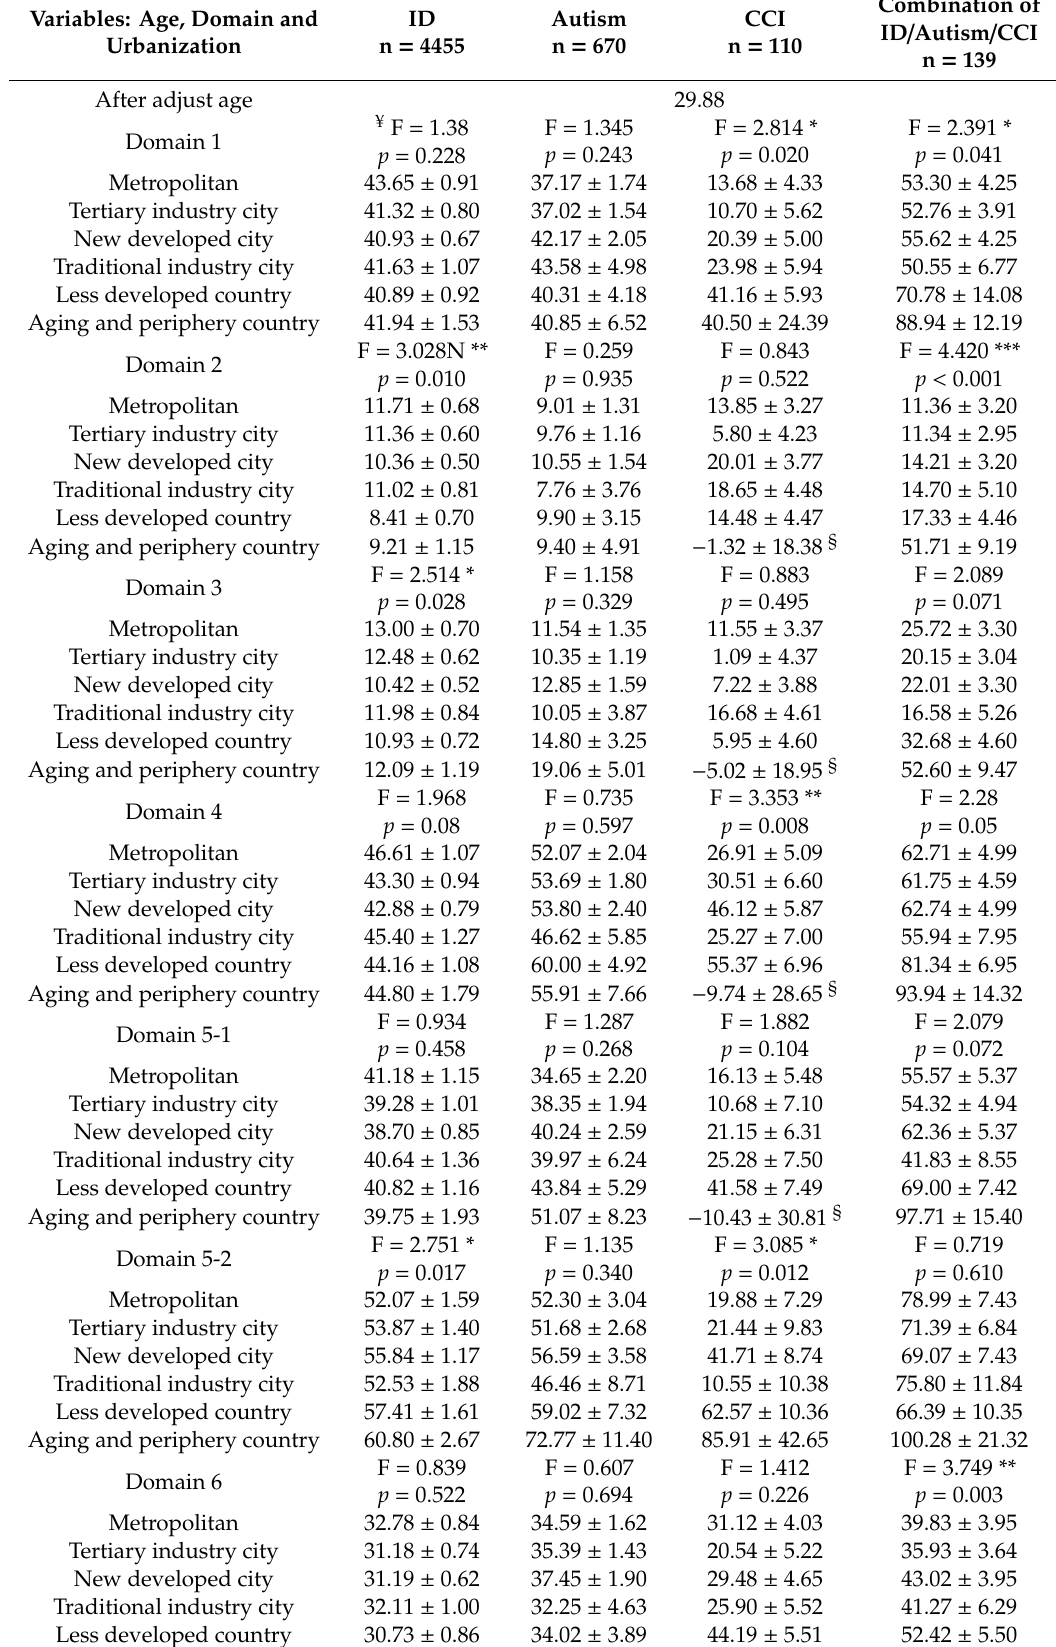
Table 4. The functioning scores of performances (mean ± SD) for all after adjusted age (covariance). Variables: Age, Domain